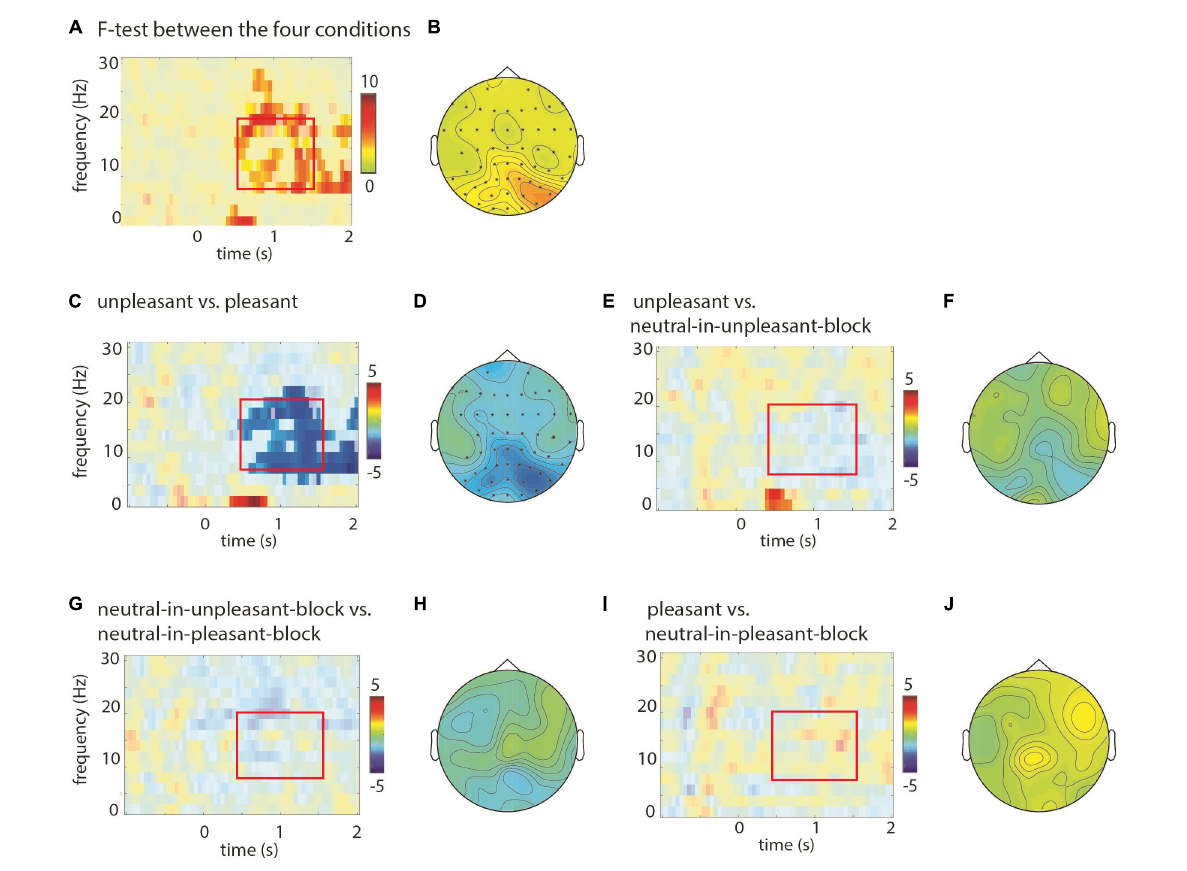
FIGURE3 Power modulations at lower frequencies with respect to valence of the pictures. Time-frequency representations of power when comparing conditions ( F/t -statistics), masked for significance, at sensor PO3. Topographical representations are based on averaged data for the latency 0.5–1.5 s and a frequency range from 8 to 20 Hz. Significant sensors are displayed with an asterisk in the topographical representation. (A) The F -test between the four conditions revealed that alpha and beta power is modulated in a condition specific manner ( p < 0.05; controlled for multiple comparisons). (B) Topographical representation for the effect shown in panel (A) revealed posterior modulation. (C,D) A stronger decrease in alpha and beta power was observed posteriorly for unpleasant compared to pleasant pictures. (E,F) Apart from the evoked activity (the low frequencies < 5 Hz) there was no significant difference between the unpleasant and neutral-in-unpleasant-block pictures. (G,H) There was no difference when comparing neutral pictures from the unpleasant and pleasant blocks, (I,J) neither for pictures of the pleasant vs.